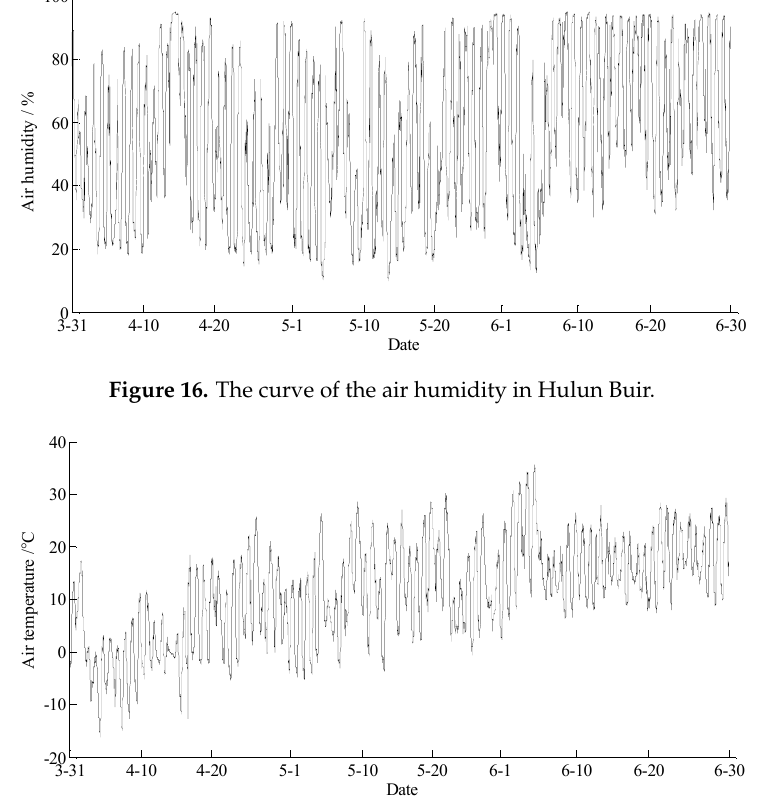
Figure 17. The curve of the air temperature in Hulun Buir.